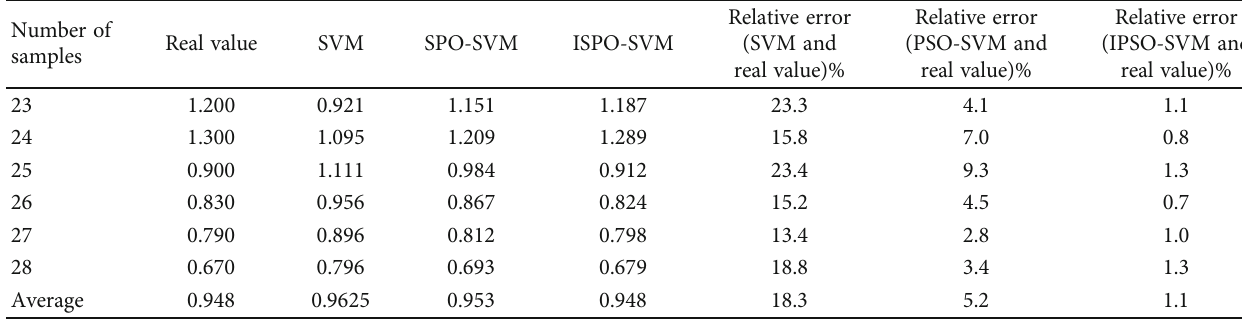
Figure 3: Comparison of MSE accuracy of di ff erent models. Table 2: Relative error table of prediction results of di ff erent